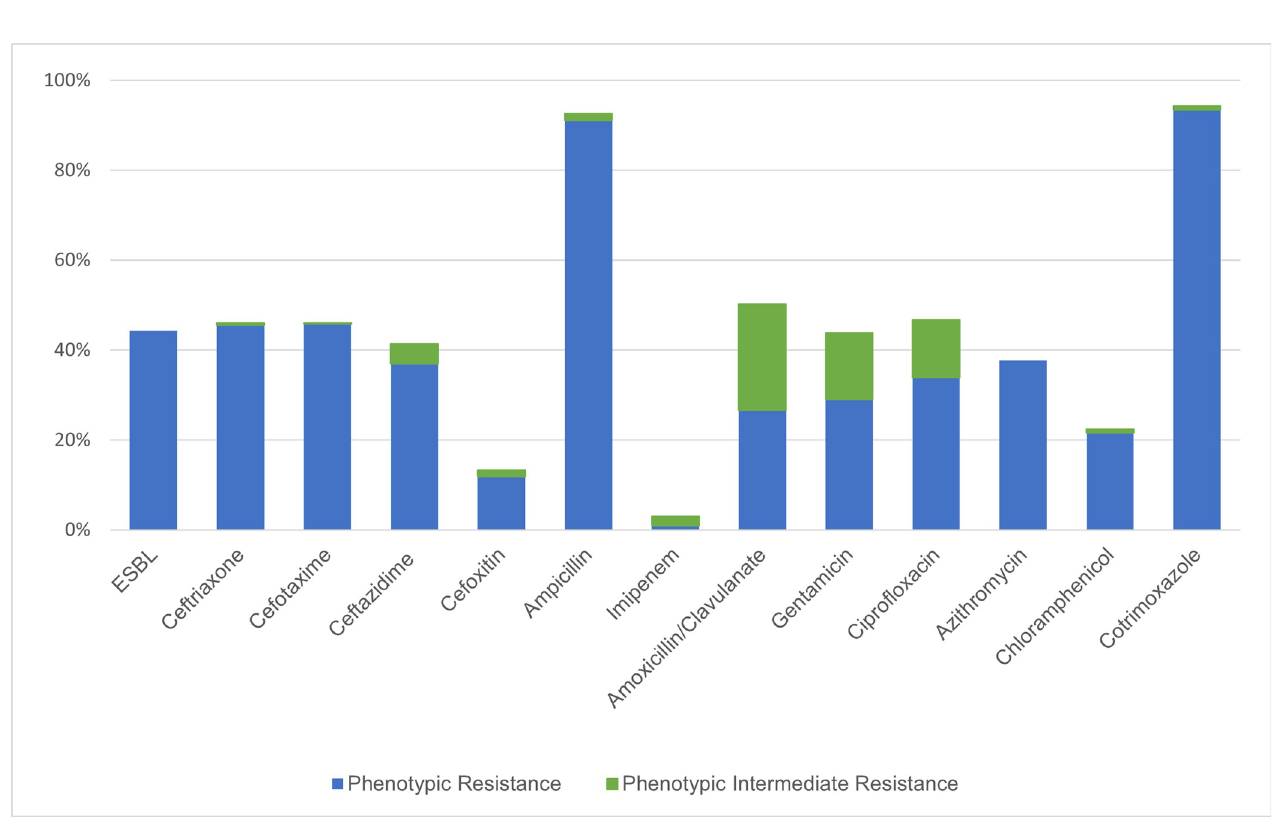
Fig 2. Prevalence of children with E . coli isolates at hospital discharge in Kenya resistant to selected antibiotics (N = 406). Resistant isolates are determined by the sizes of clearings around antibiotics measured using disc diffusion antimicrobial susceptibility testing and classified as “resistant” or “intermediate” by CLSI